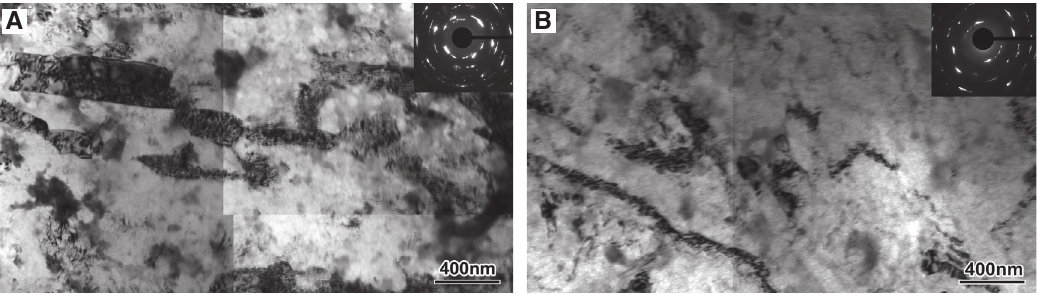
Figure 6 TEM micrographs of the TD section in the 7075 layer of the processed samples: (A) 1280 layer composite sheet of 75% cold rolling; (B) 1280 layer composite sheet after 75% cold rolling and then annealing at 150 ° C for 30 min. Both the SAED patterns in (A) and (B) were taken from a ∼ 1.2- μ m-diameter sample area.